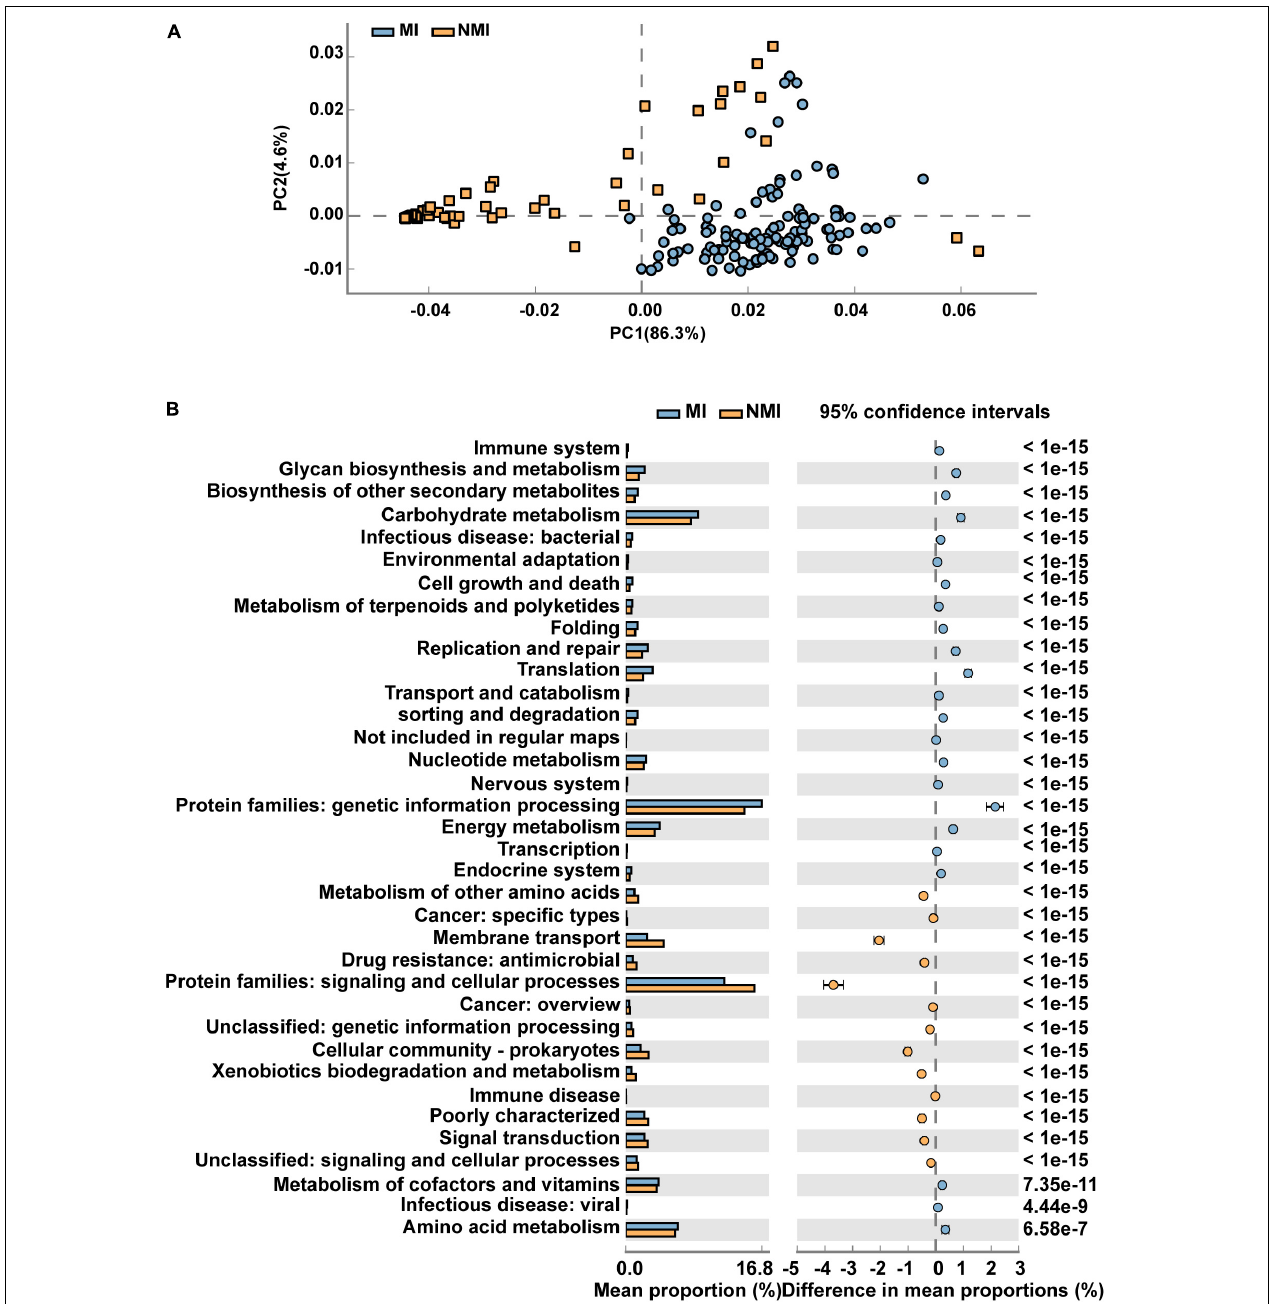
FIGURE 5 | Differential functional pathways for 20 biomarker taxa of high importance predicted by PICRUSt2. (A) PCA plots of differential functional pathways for the 20 biomarkers in medicinal insect (MI) and non-medicinal insect group (NMI) in PathwayL2. Blue indicates medicinal insect gut microbiota and orange indicates non-medicinal insect gut microbiota. (B) Extended histogram of the differential functional pathways of the MI and NMI groups in PathwayL2. Histogram indicates the mean proportion (%) of differential MetaCyc pathways predicted by PICRUSt2. Differences between groups are shown with 95% confidence intervals, and only the fractions with p < 0.00001 after Benjamini–Hochberg FDR correction using Welch’s t -test are shown. Blue indicates the medicinal insects gut microbiota, and orange indicates the non-medicinal insects gut